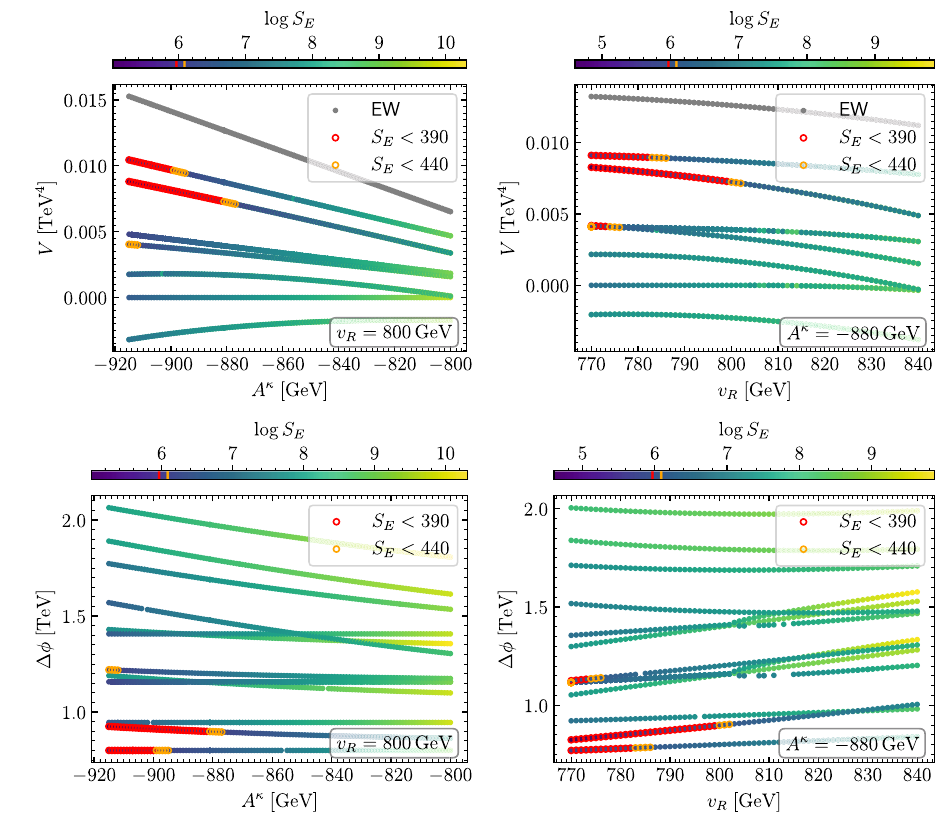
Fig. 2 EW minimum and deeper unphysical minima as a function of A κ for fixed v R (left) and as a function of v R for fixed A κ (right). Shown are for each local minimum the potential values V (top) and the field space distance between the unphysical minimum and the EW minimum (cid:11)φ (bottom). The colors of the points indicate the value of the euclidean bounce action S E . Points with S E < 390 are highlighted with a red edge, while points with 390 ≤ S E ≤ 440 are highlighted with an orange